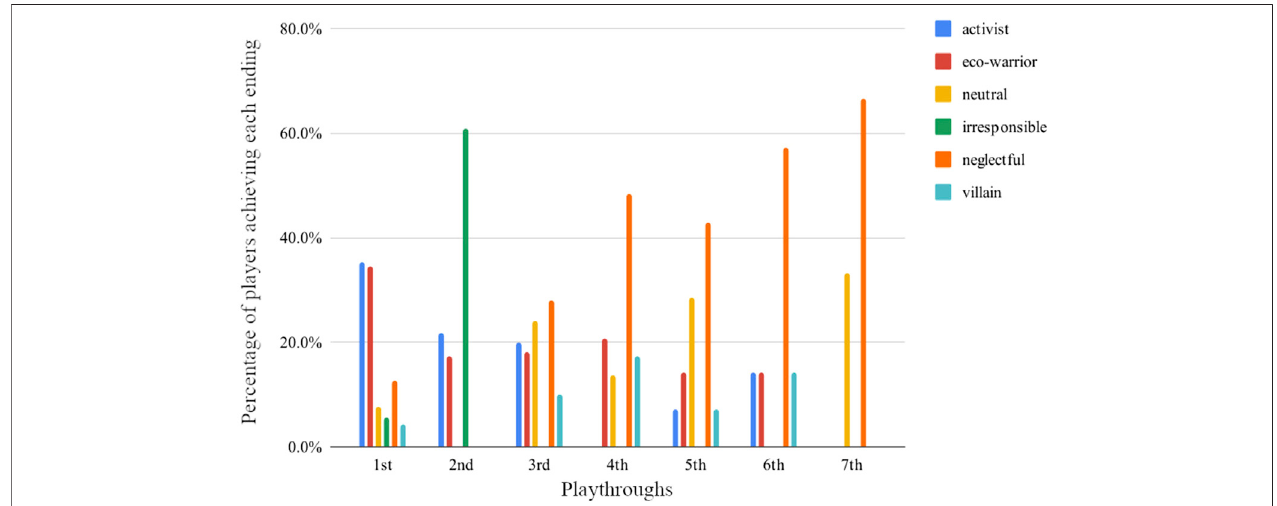
FIGURE 1 | Endings per